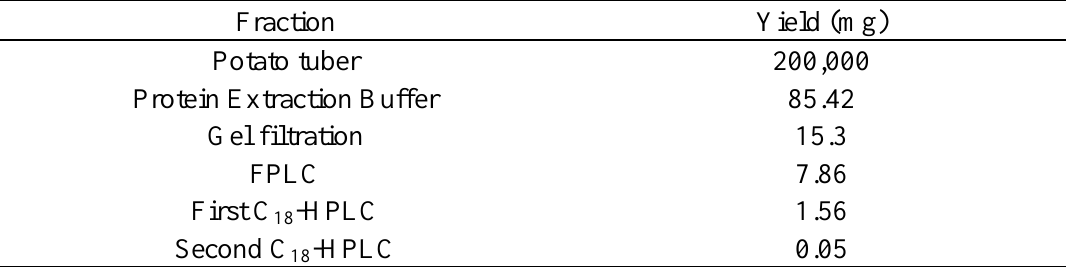
Table 1. Steps in the purification of Potide-J from potato